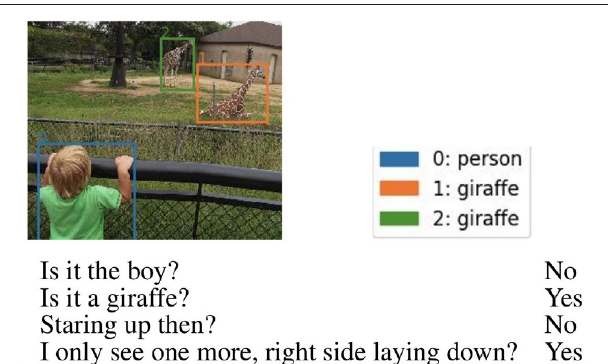
FIGURE 4 | Prolific interface: Humans were given a dialogue, an image with colored bounding boxes, and a numbered list of candidates with colors matching those of the bounding boxes. They had to use the keyboard device to choose the